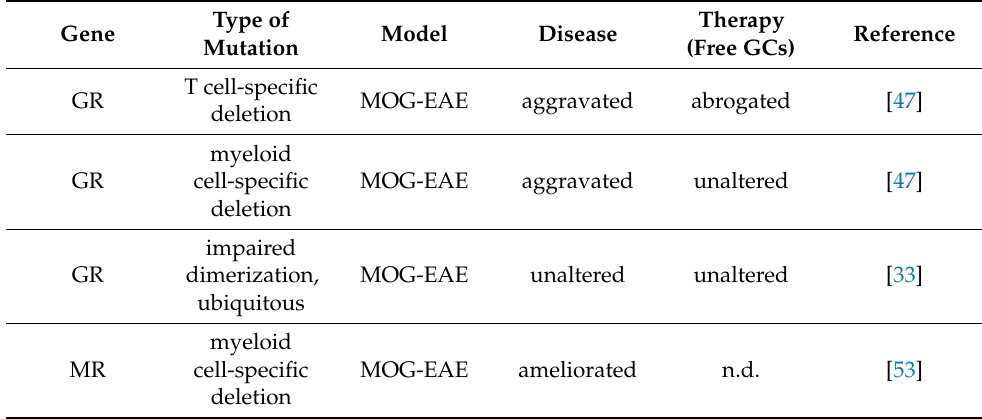
Table 1. Phenotype of selected genetic mouse models of neuroinflammatory diseases. MOG-EAE: EAE induced by immunization with MOG 35–55 peptide in CFA. n.d.: not determined.